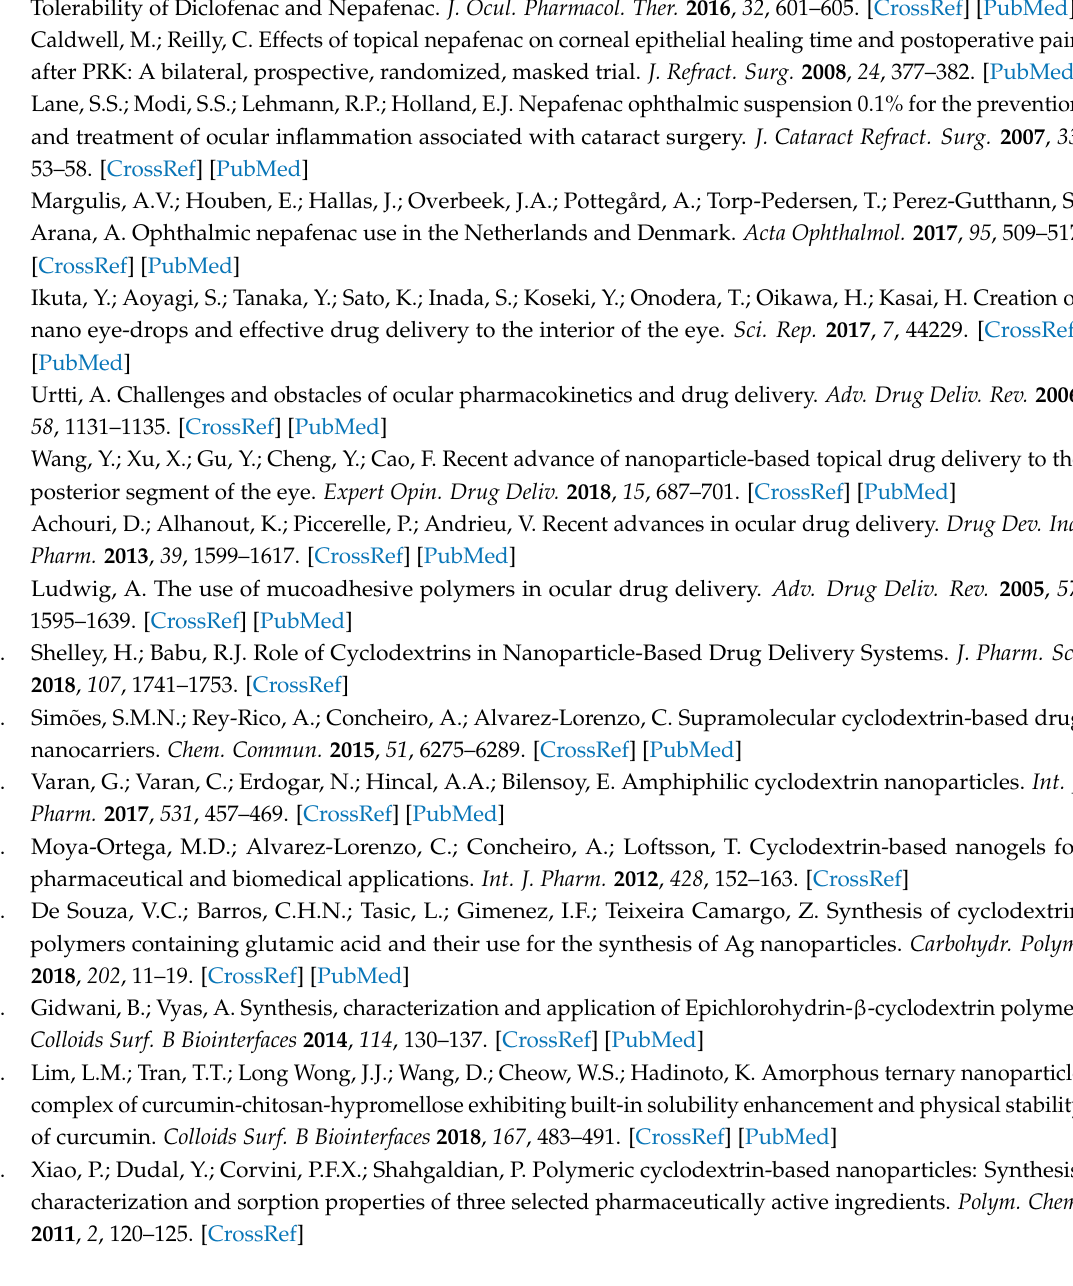
Figure S1: Chemical structure of (a) natural cyclodextrins ( α -, β - and γ -CDs) and (b) their hydroxyl-propyl derivates (HP α -, HP β - and HP γ -CDs), Figure S2: H-NMR spectra of (a) HP β CD alone (top) and their complex (bottom) and (b) γ CD alone (top) and their complex (bottom), Table S1: Effect of cyclodextrins and excipients on osmolality, viscosity and size of binary and ternary systems with nepafenac, Table S2: Chemical shift corresponding to free nepafenac alone and in the presence of γ CD or HP β